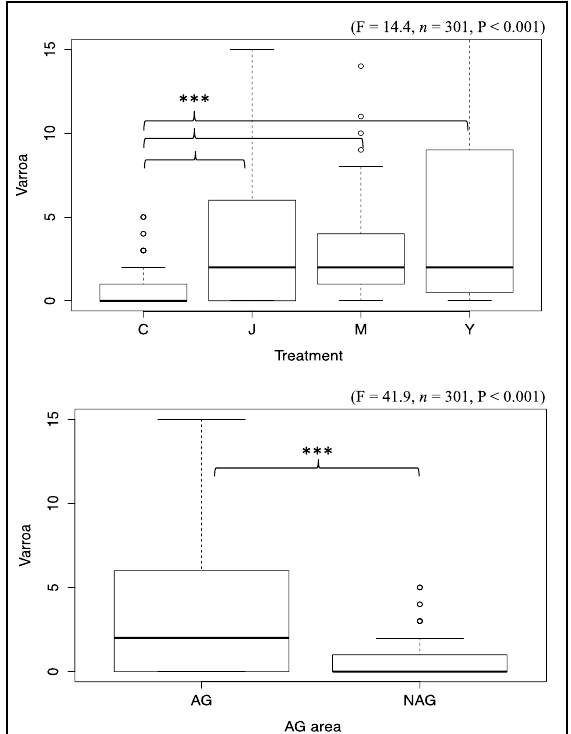
Figure 2. Overall level of varroa infestation exposed by treatment and AG area. Abbreviation codes are (C) Chickasaw, (J) Jackson, (M) Milan, and (Y) Yum-Yum. The Boxplots (aka, Box and whisker Plots) summarize the data distribution based on minimum, first quartile, median, third quartile,